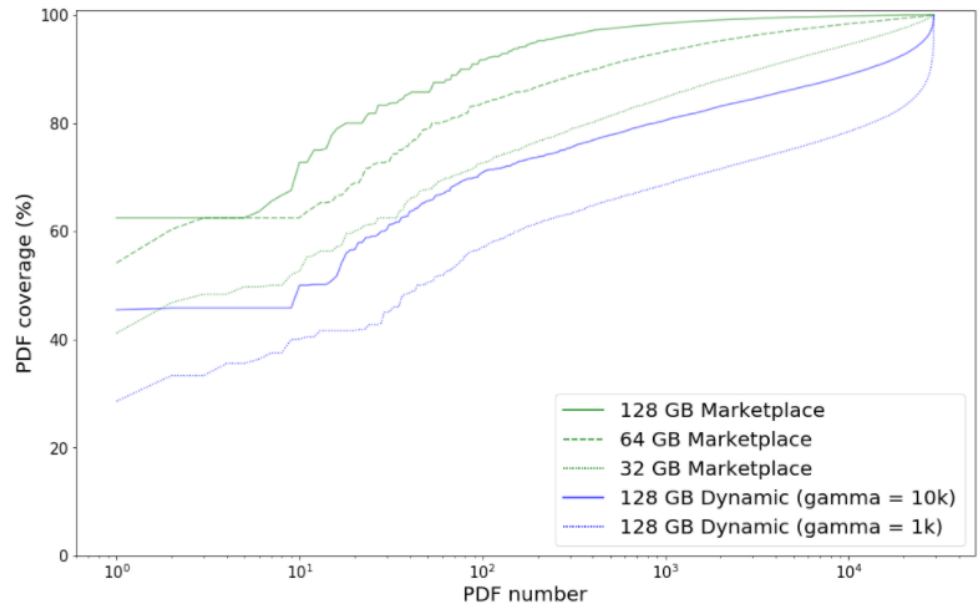
Figure 7. Database coverage of marketplace and dynamic n-gram systems. The coverage of a single PDF is defined as the percentage of the corresponding bootleg score that is represented in the database, and each curve shows the coverage of all piano PDFs in IMSLP sorted from least coverage (left) to most coverage (right). Note that the x-axis is on a log